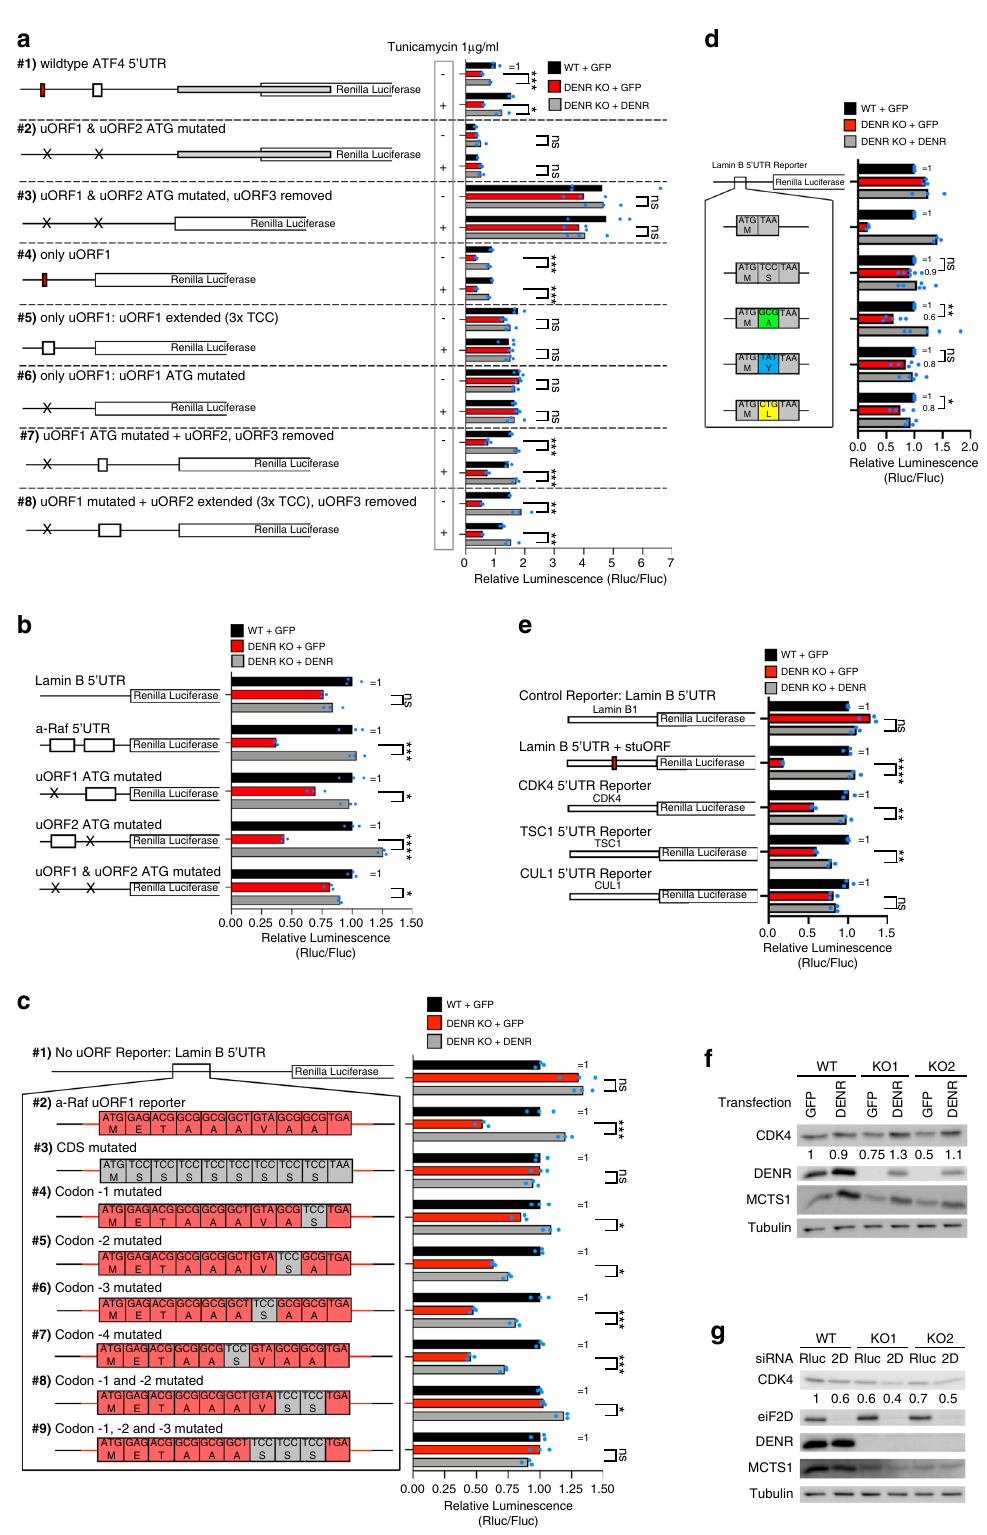
DENR (cid:129) MCTS1 expression correlates with ATF4 activity in cancer . Since ATF4 helps cells cope with stress, it plays a central role in the survival of cancer cells, which are exposed to pro- teotoxic stress, hypoxia, nutrient stress, DNA damage, and oxi- dative stress. For instance, ATF4 is required for transformation of fi broblasts by H-rasV 12 , it is essential for prostate cancer cells to grow and survive 23 , and it has been implicated in chemotherapy